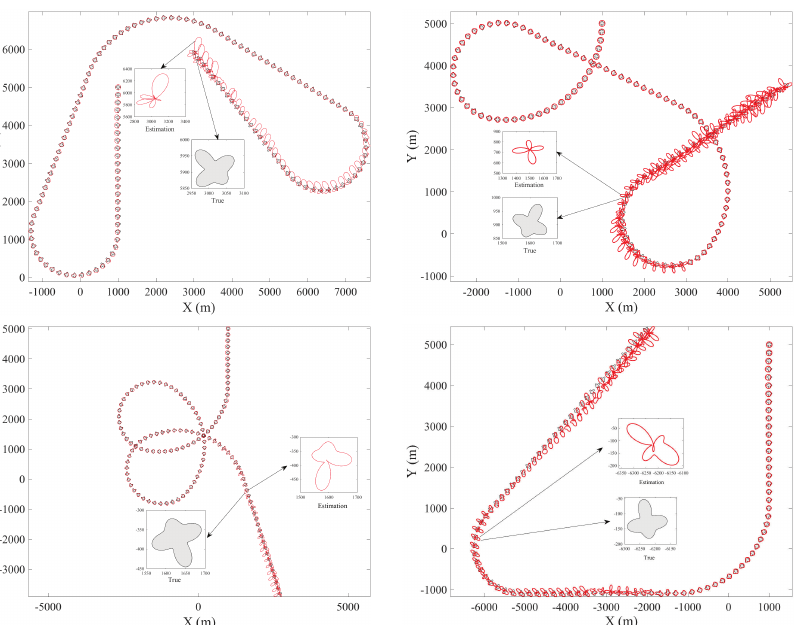
Figure 6. Shape divergence in some typical